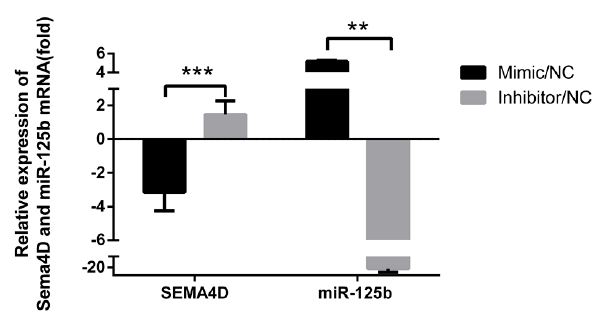
Figure 3. miR-125b suppresses Sema4D expression. DF1 cells were transfected with the miR-125b mimic, inhibitor, and negative control (NC). miR-125b and Sema4D expression was tested by RT-qPCR 48 h after transfection. Transcript levels of miR-125b and Sema4D were normalized to chicken 5S rRNA expression levels. Data are provided as means ± standard deviation values of three replicates from a representative experiment. ** P < 0.01; *** P < 0.001.